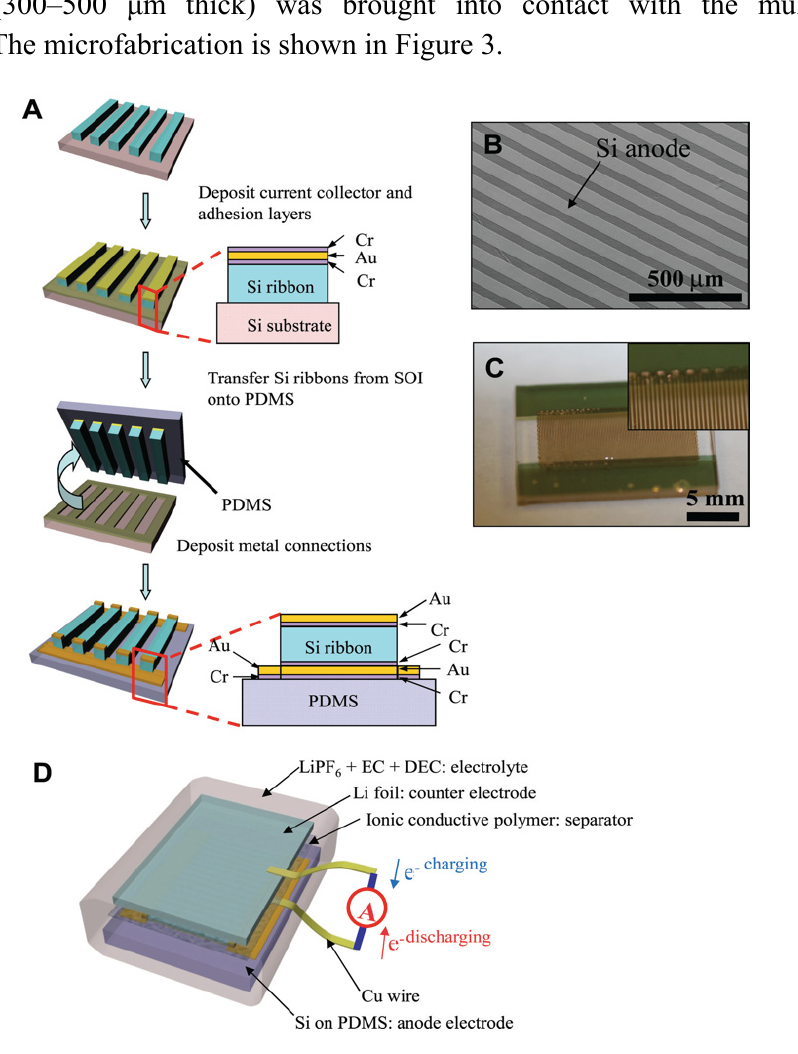
Figure 3. Half-cell lithium ion battery based on Si anodes, produced by microfabrication. Reproduced with permission from [58]. Copyright Wiley, 2012. ( A ) Schematic steps to fabricate the Si anodes on Poly(dimethylsiloxane) (PDMS) substrates; ( B ) A SEM image of Si anode on PDMS; ( C ) Optical images of fabricated anode before assembling; and ( D ) an illustration of the battery cell